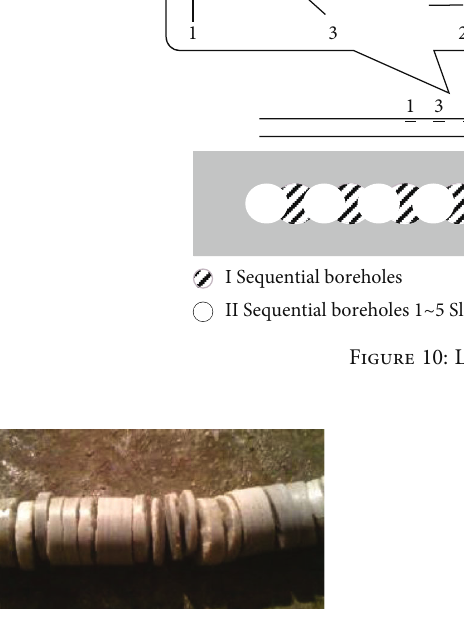
Figure 11: Borehole core after